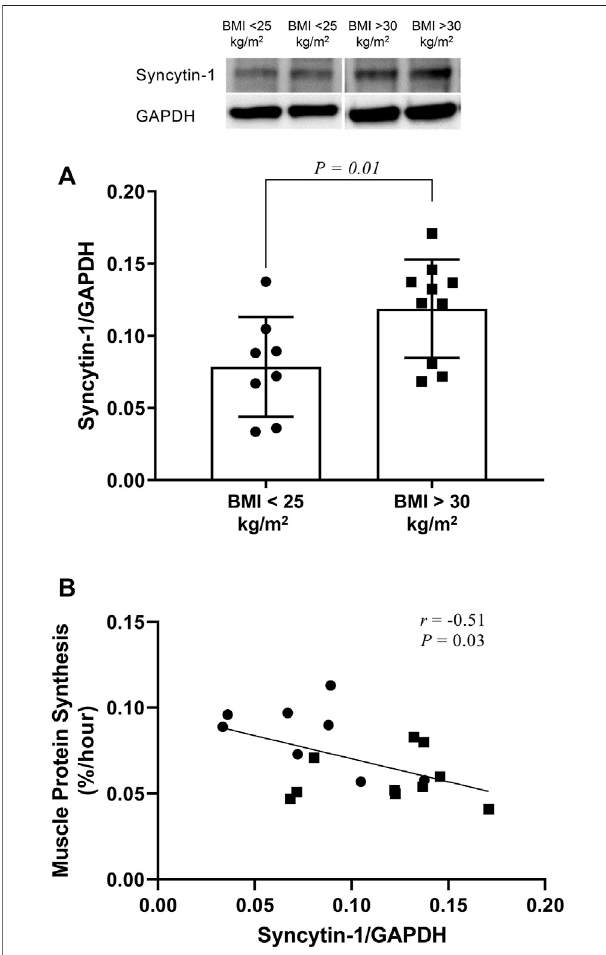
FIGURE 1 | Western blot analysis of syncytin-1 expression in skeletal muscle of subjects with increased BMI (i.e,. BMI > 30 kg/m 2 ) and control subjects (i.e., BMI < 25 kg/m 2 ). Individual data points are shown along with mean ± SD (A) . Pearson product-moment correlation (r) between